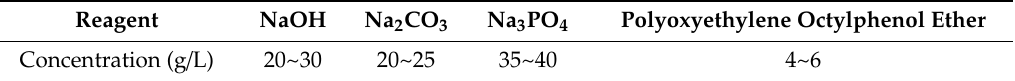
Table 2. Formulation of alkali washing and degreasing.